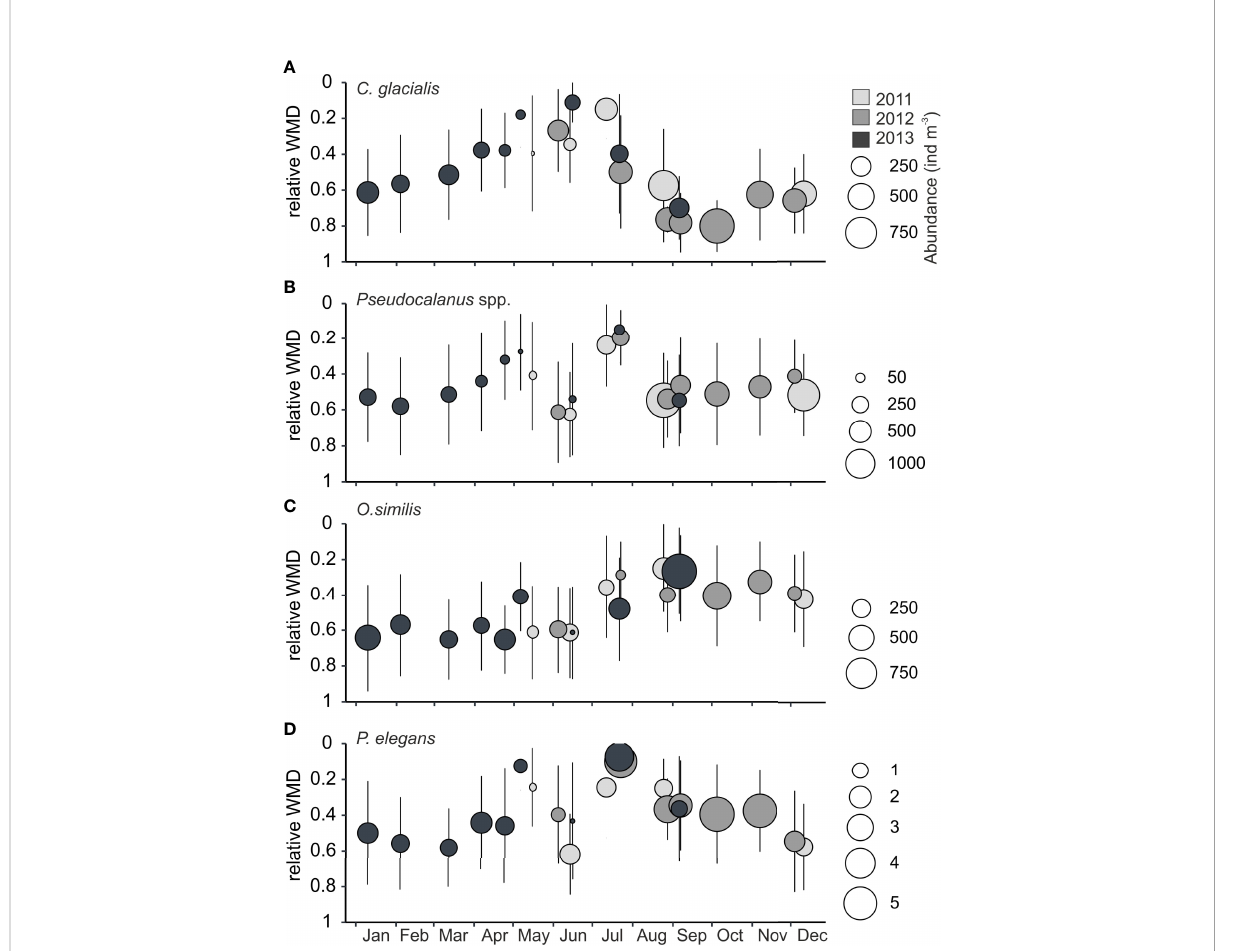
FIGURE 6 Relative weighted mean depths (WMDs) against day of year for species with high seasonal variability in WMD Billefjorden, years 2011-2013. Error bars indicate the spread (Z s ) of individuals over the water column, bubble size re fl ects mean abundance in water column (ind m − 3 ), and color indicates year. (A) Calanus glacialis , (B) Pseudocalanus spp., (C) Oithona similis , and (D) Parasagitta elegans. Note the differences in scale between species. The relative WMD is the ratio of WMD to the total sample depth, i.e., a WMD of<0.5 indicates that the taxa was centered in the upper half of the water column, a WMD closer to 1 indicates that the distribution was centered in the deeper part of the water